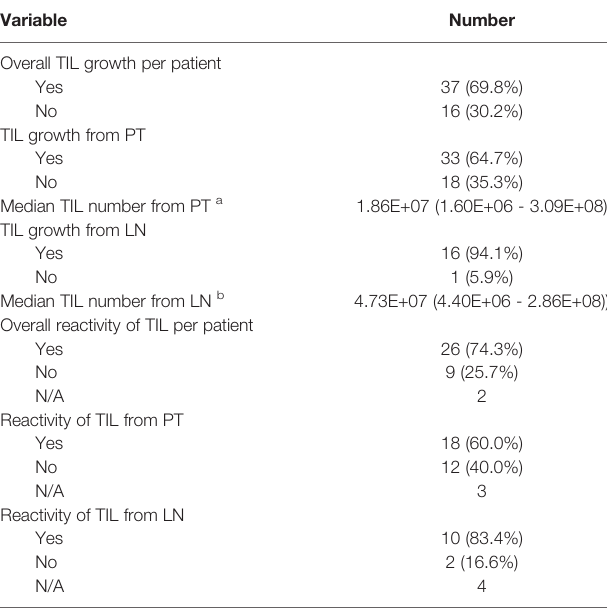
TABLE 2 | Expansion of tumor-reactive TIL in 53 bladder cancer